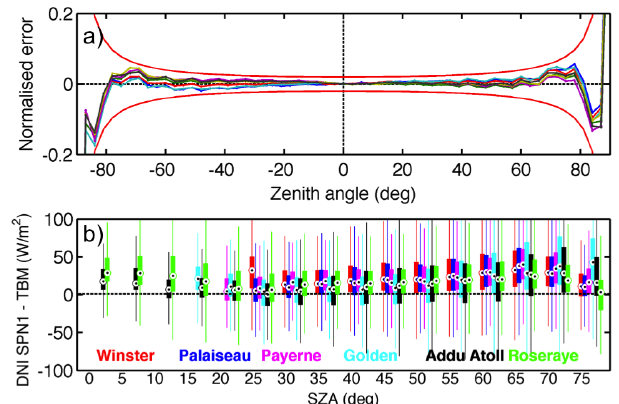
Figure 4. (a) Cosine response from laboratory tests. Shown error is normalized by incoming beam intensity. Thermopile readings are shown in different colours. Red envelope lines show the ± 2% limits (from ISO 9060/1990). (b) SPN1 – TBM differences distributions for DNI, GHI and DHI as a function of bins of SZA at all stations. Box size represents the percentiles 25 and 75. Whiskers account for 99.3% of data under Gaussian distribution assumption.